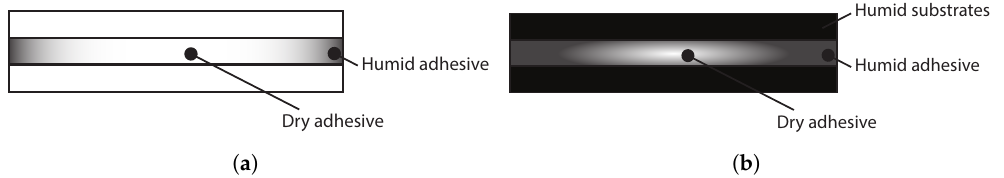
Figure 12. Water uptake of RJs with aluminum ( a ), and PBT-GF30 ( b ) substrates as expected from the numerical